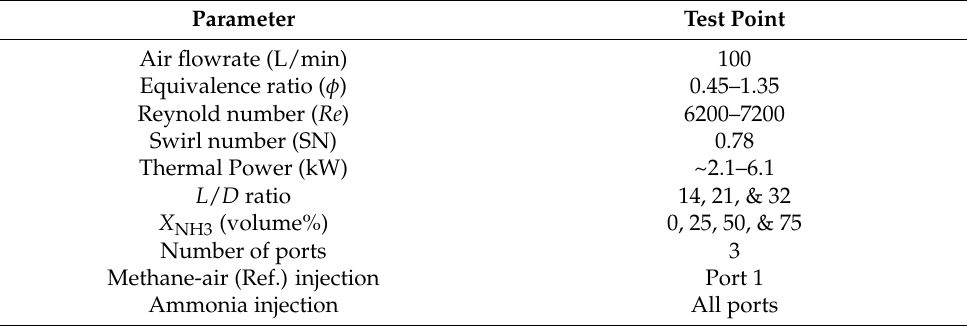
Table 2. Summary of the tested